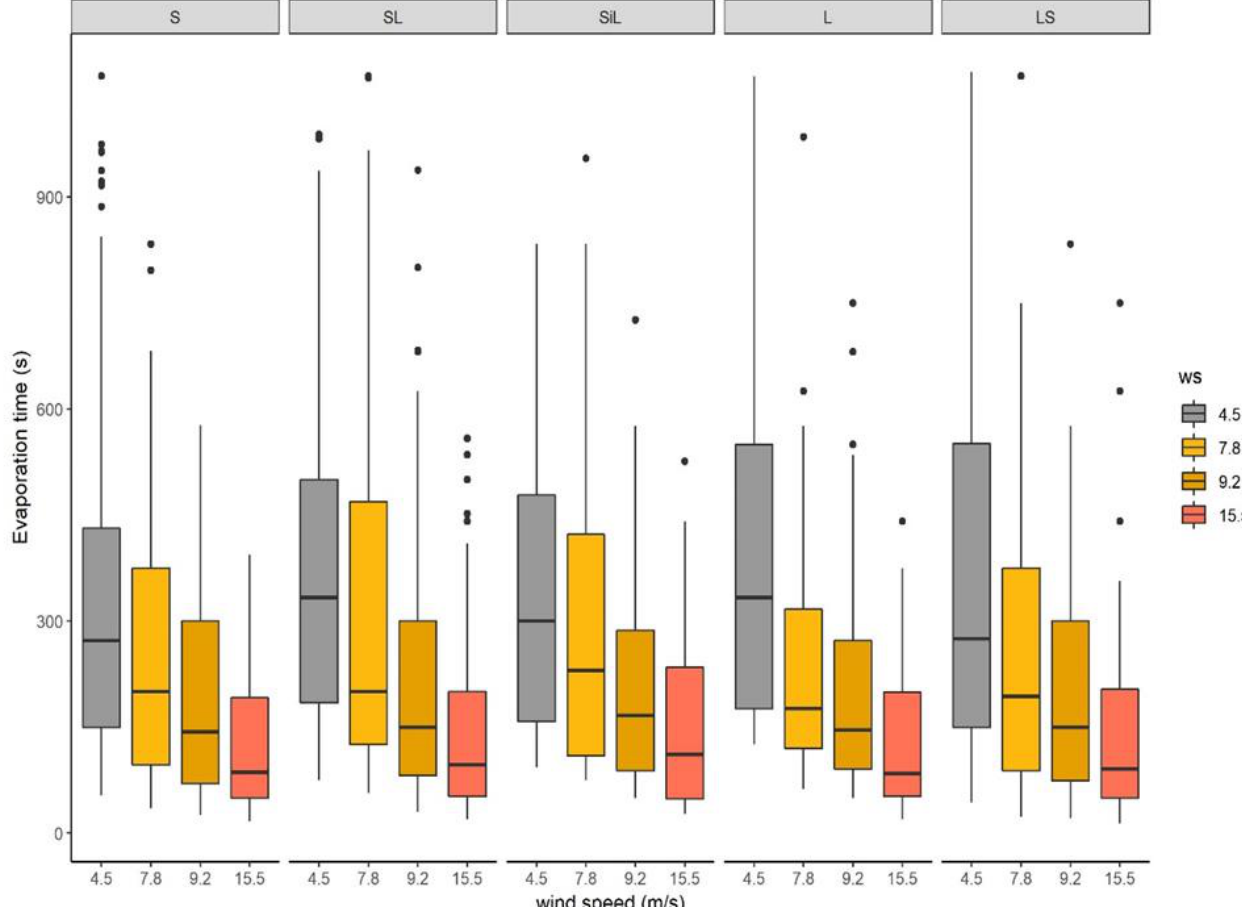
Figure 4. Variation of evaporation time by soil textures at different wind speeds (unit is expressed in the duration needed to